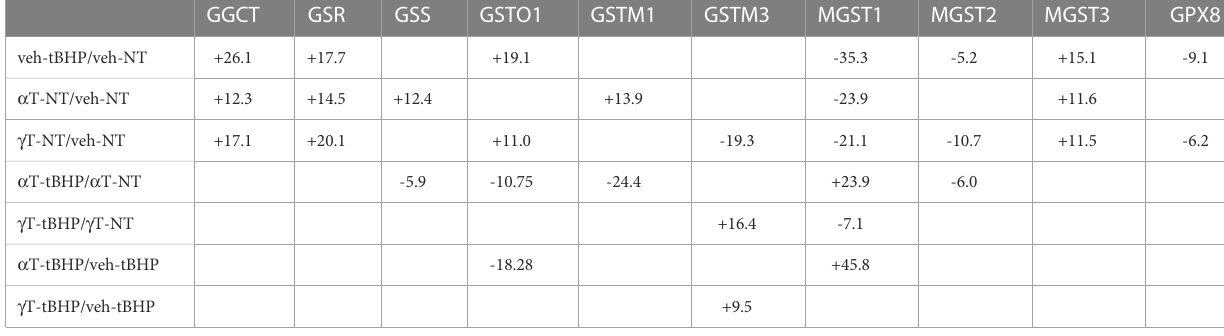
TABLE 7 The effect of a T or g T with tBHP on the expression of proteins involved in glutathione metabolism and transfer. GGCT